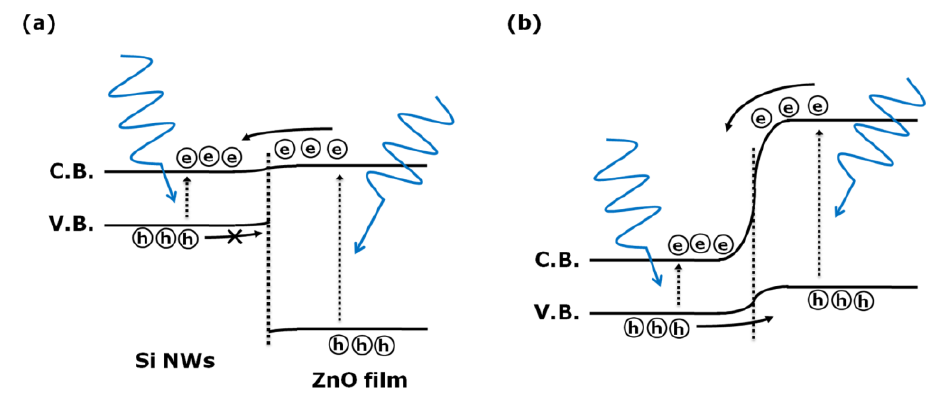
Figure 6. Schematic energy band diagrams of a p -type Si NWs/ n -type ZnO film heterojunction photodiode coupled with a Si NWs-FET in forward bias condition under the illumination of the 325-nm wavelength light. The gate voltages of (a) +3 and (b) −9 V are applied on the gate electrode,